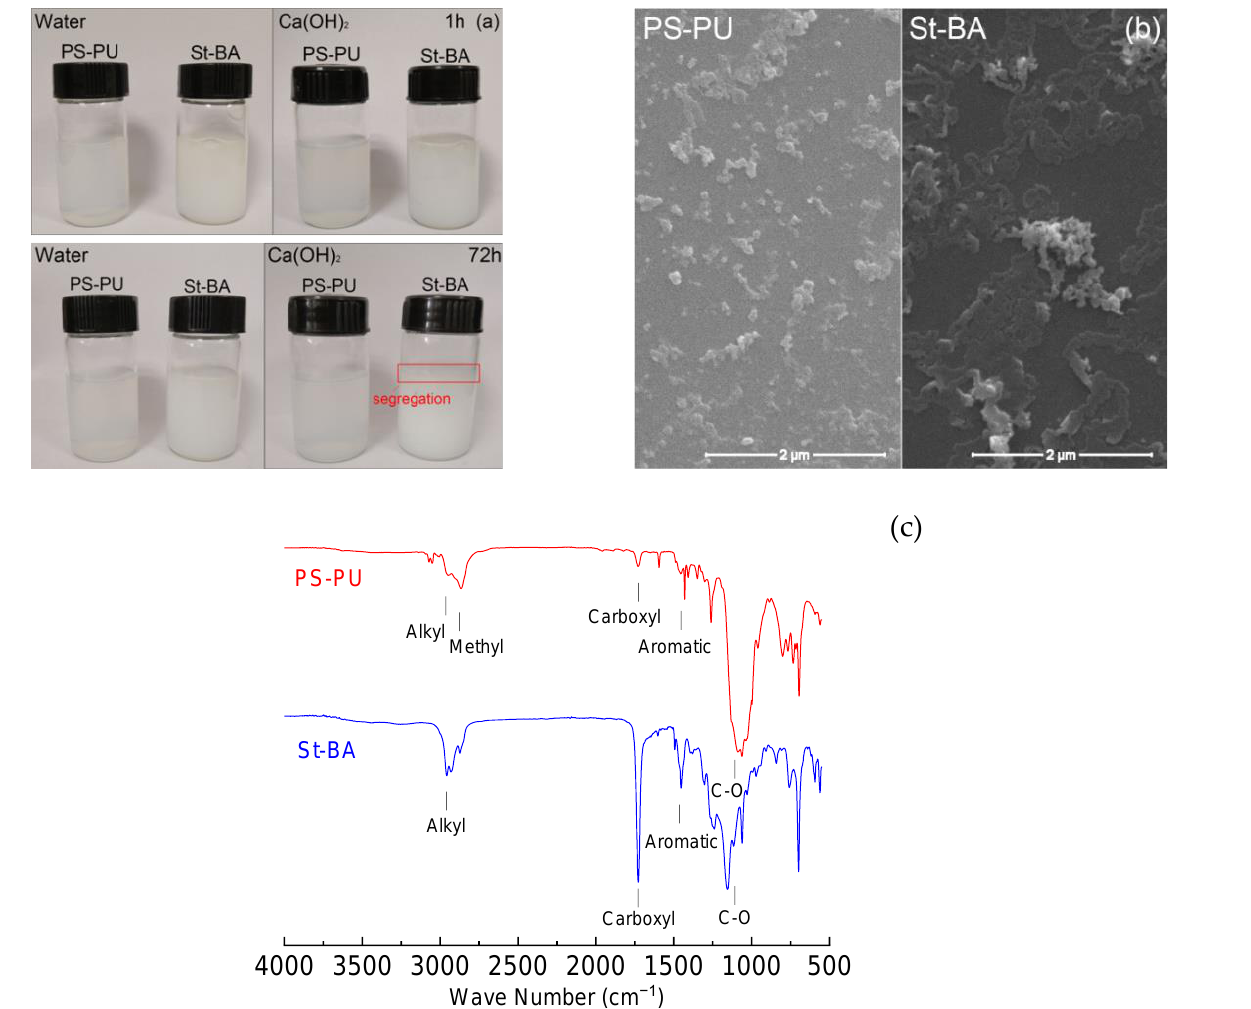
Figure 2. Dispersion status of the latex samples ( a ), SEM images of the samples ( b ) and FT-IR spectra of the samples ( c ).